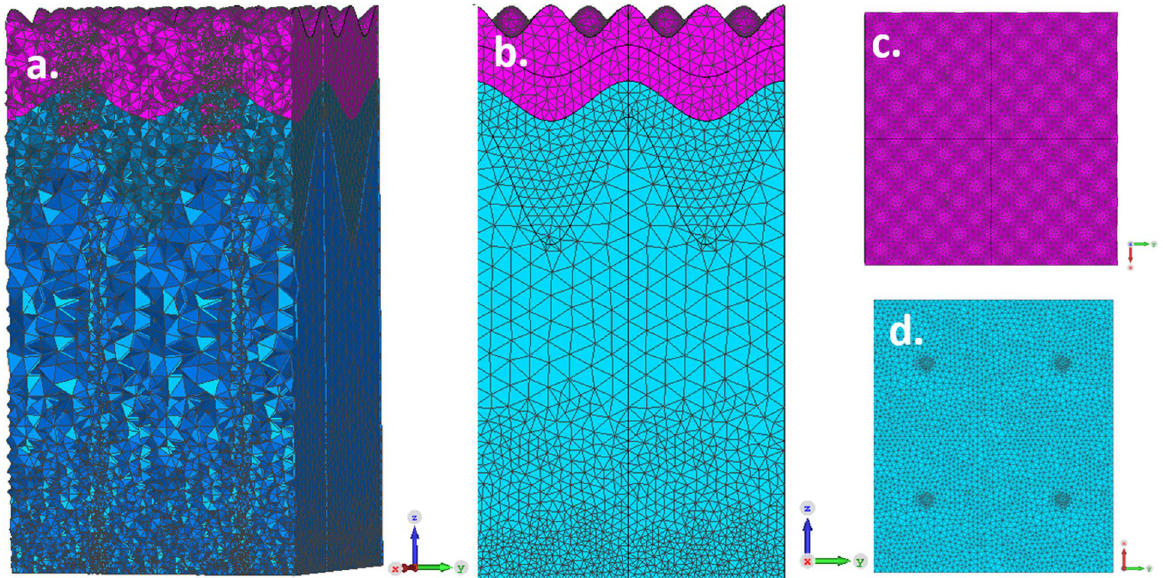
Figure 5. Mesh view of the human skin model. ( a ) a 3D view of the zy-plane, ( b ) a 2D view of the zy-plan. The adaptive mesh id clearly shown, as different areas of the model have different division of tetrahedral mesh cells, ( c ) top view. A more fine division to mesh cells is taking place due to the curved sinusoidal nature of this surface. ( d ) Bottom view. Here, as well, a finer mesh division is taking place to overcome the sharp edges of this surface. This figure was generated using CST STUDIO SUITE v2021 30 , https:// www. 3ds. com/ produ cts- servi ces/ simul ia/ produ cts/ cst- studio-